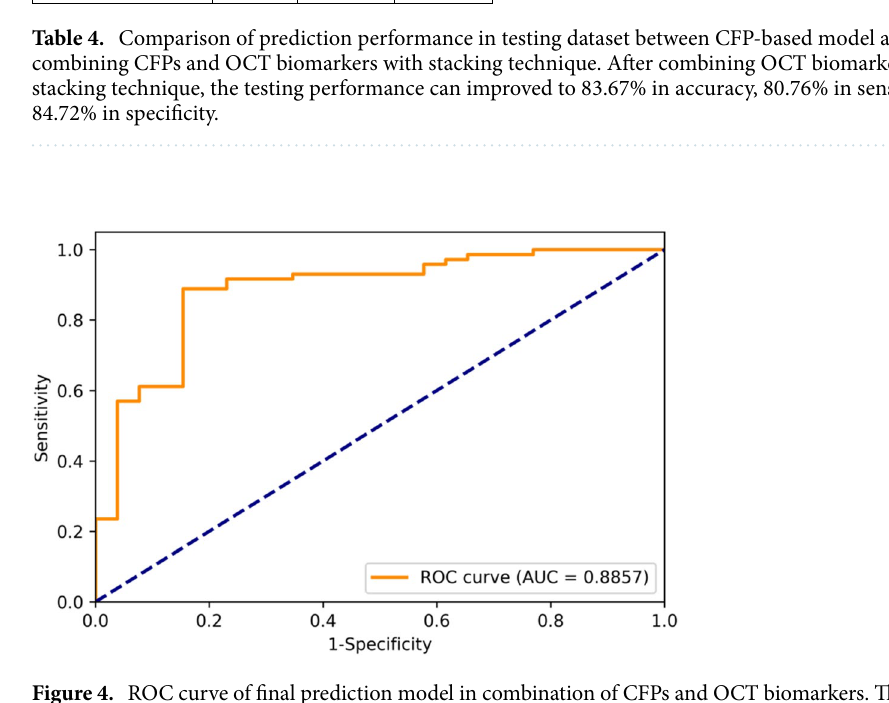
Figure 4. ROC curve of final prediction model in combination of CFPs and OCT biomarkers. The area under curve (AUC) showed